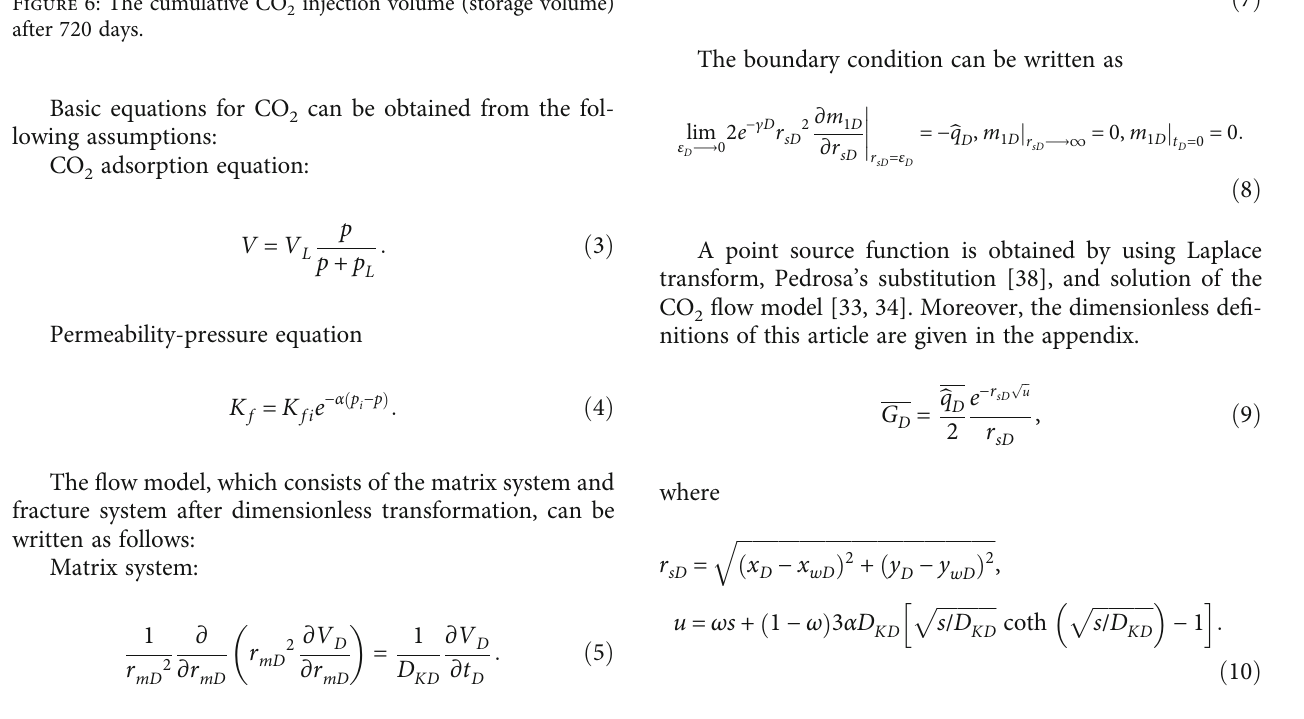
injection volume (storage volume) 2